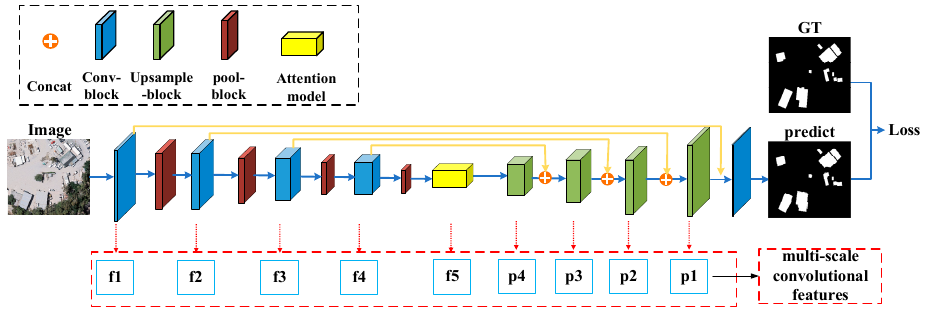
Figure 2. Prior semantic information generation network.